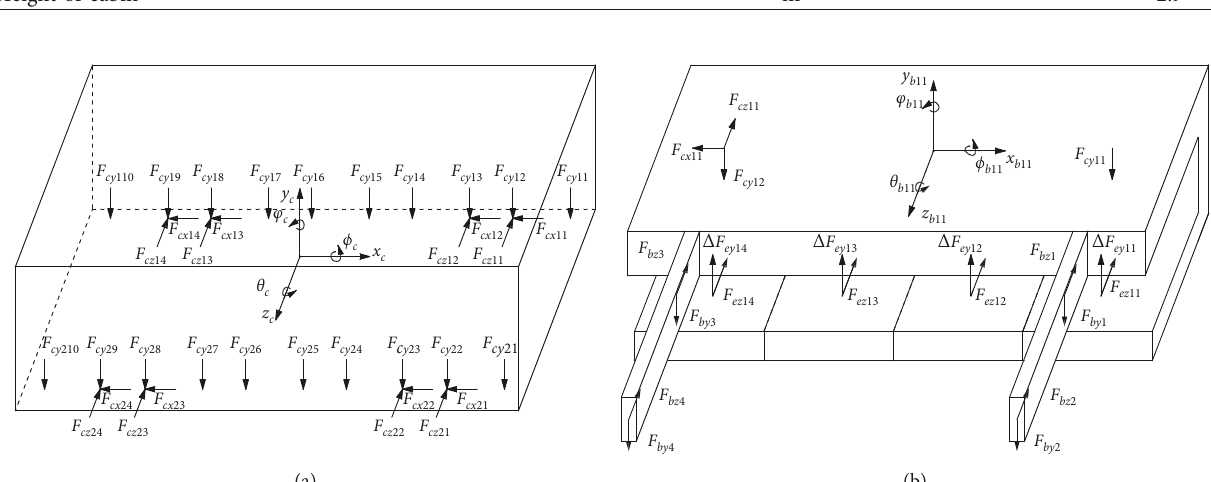
Figure 2: Distribution of loads for the cabin and the first bogie. (a) Distribution of spring-damping forces in the cabin. (b) Distribution of electromagnetic forces and spring-damping forces in the first